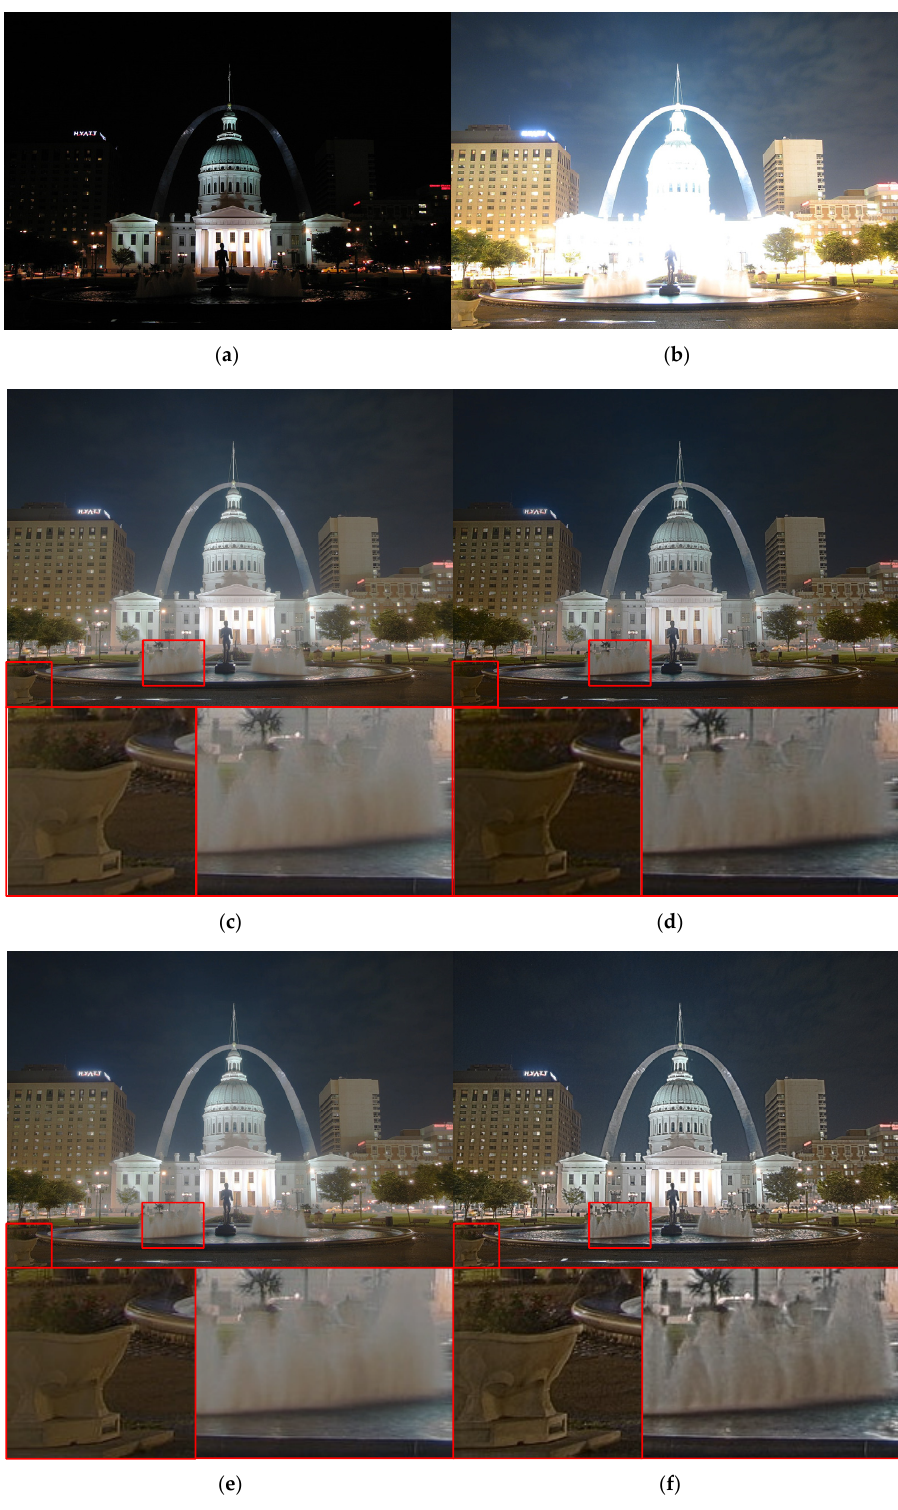
Figure 11. Input and result images (1): ( a ) Under-exposed image, ( b ) Over-exposed image, ( c ) DenseFuse, ( d ) U2Fusion, ( e ) TransMEF, ( f ) Proposed model.